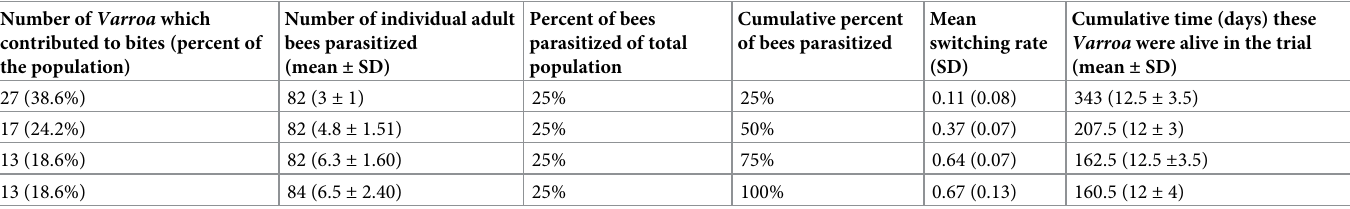
Varroa did not equally contribute to the number of parasitized bees in the trials. Mites that were the lowest frequency switchers contributed to fewer parasitized bees than the highest fre- quency switchers while, on average surviving for equal times in the study (Table 2). Time did not explain a majority of the variability in the number of bees parasitized within the trials (WLS regression, R 2 = 0.571, F (1, 68) = 90.59, p < 0.0001, Fig 3). Experiment 4: Relative risk of Varroa parasitism on adult worker bees The presence of a Varroa among a group of worker bees was associated with increased bee mortality (Fig 4). Overall survivorship of adult bees was highest in the unchallenged group and significantly different from any of the Varroa challenged groups (Kaplan-Meier survival analy- sis, p < 0.0001, N = 303). Bees in the challenged groups died at faster and higher rates than bees within the unchallenged group (Kaplan-Meier survivor analysis, p < 0.0001, N = 303), however, there was no significant difference in survivorship of bees between any of the Varroa